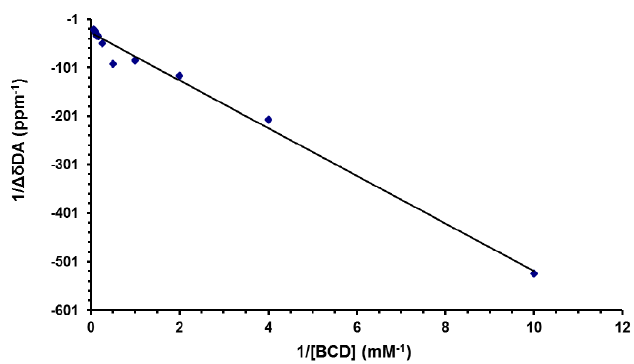
Figure 8. Graphical representation of the Benesi–Hildebrand data treatment.